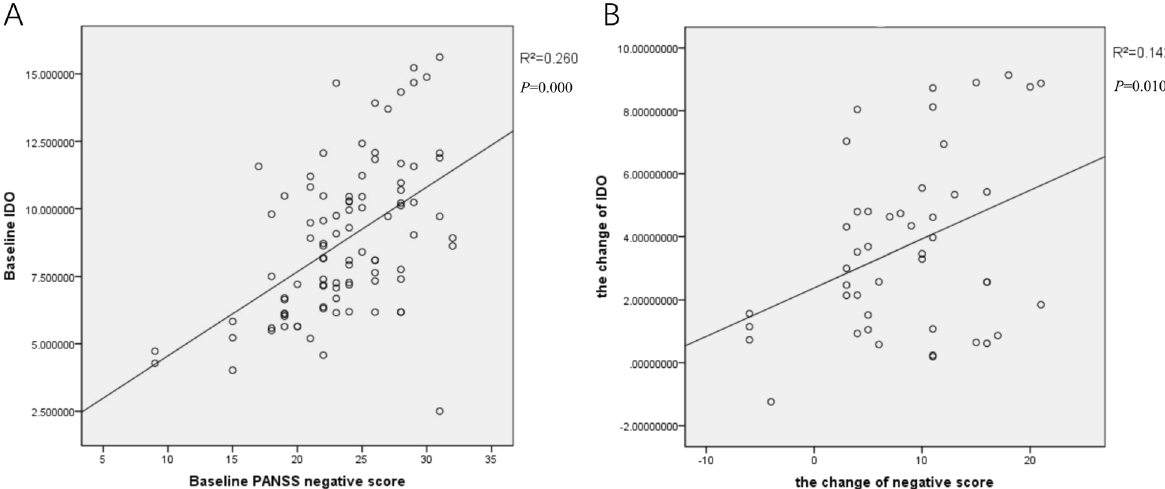
Fig. 3 Correlation coef fi cients between IDO levels and PANSS negative score. A There was a signi fi cant correlation between serum IDO levels and the PANSS negative symptom scores in all schizophrenia patients. B The reduction in the PANSS negative score showed a signi fi cant positive correlation with the decrease in serum levels of IDO in the celecoxib group. P < 0.05.